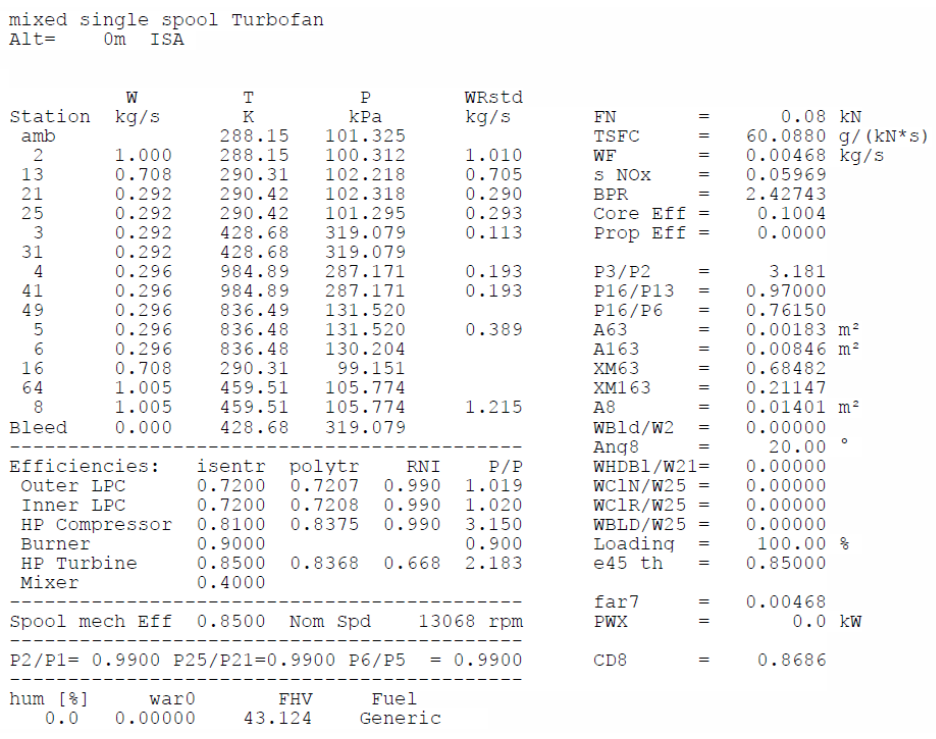
Aerospace 2019 , 6 , x; doi: FOR PEER REVIEW Figure A9. GasTurb simulation results for fan speed 21,780 RPM. Figure A9. GasTurb simulation results for fan speed 21,780 RPM.